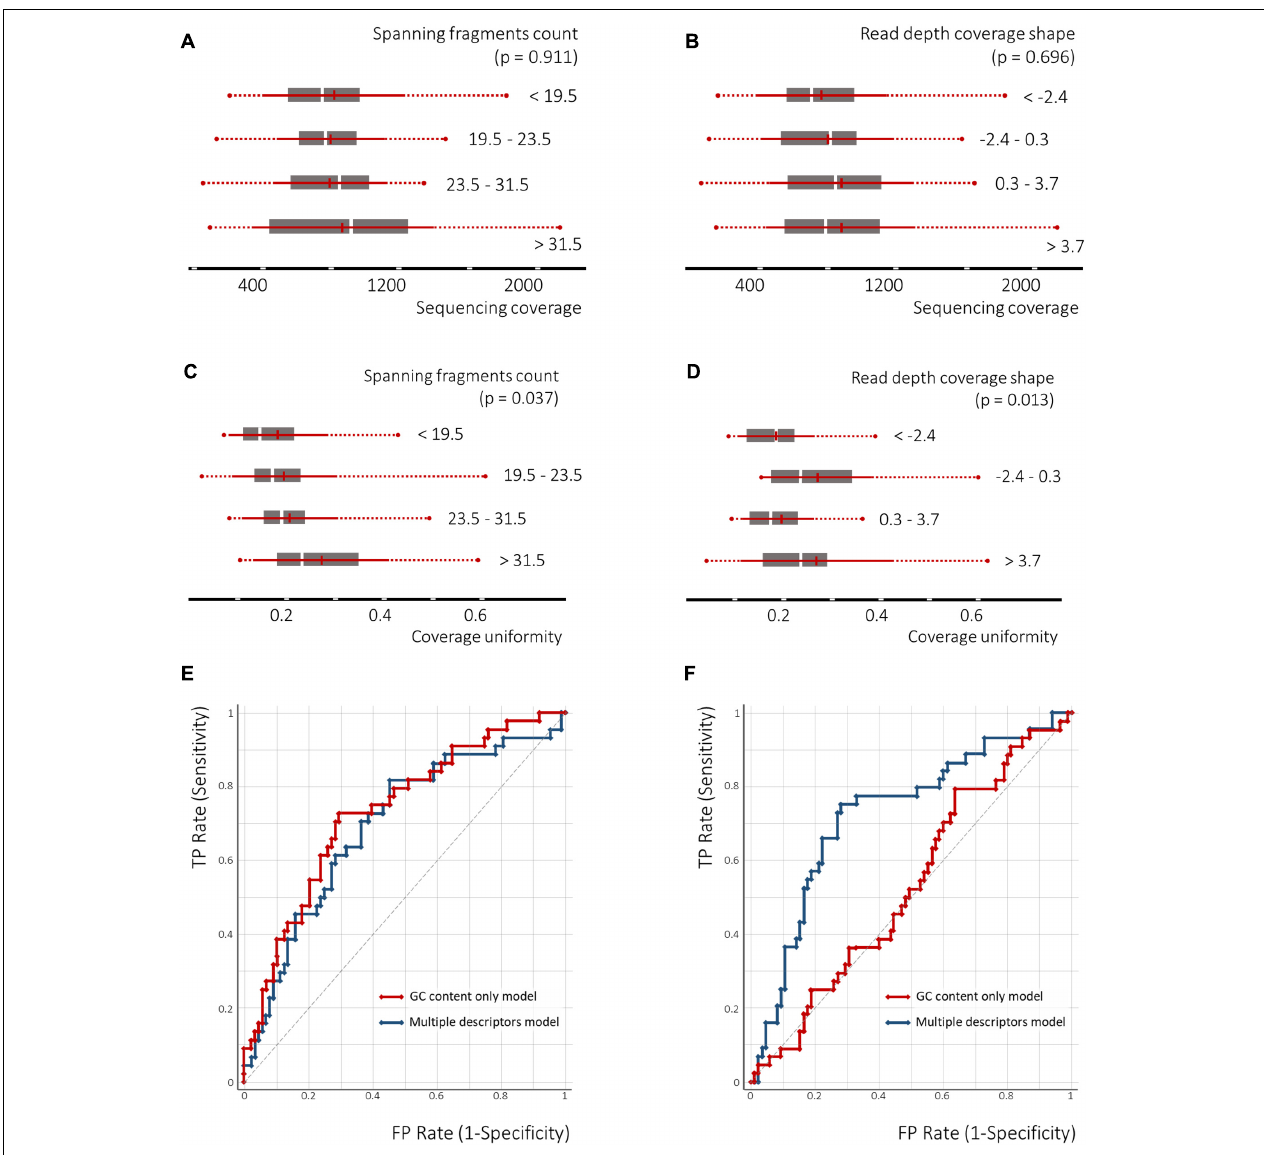
FIGURE 7 | The nucleosome-guided cfDNA fragmentation pattern facilitates the prediction of amplicon coverage uniformity across samples. The ANOVA test demonstrates dependency between spanning fragment counts and coverage uniformity as well as read depth overage shape and coverage uniformity (C,D) , though no similar relation to the mean amplicon coverage across the samples was observed (A,B) . The SVM classification model utilizing the GC content as a single feature, or in combination with the cfDNA fragmentation pattern defining features, demonstrates the significance of the latter to predict amplicon coverage uniformity across samples (F) , but not of the mean sequencing coverage across samples (E)